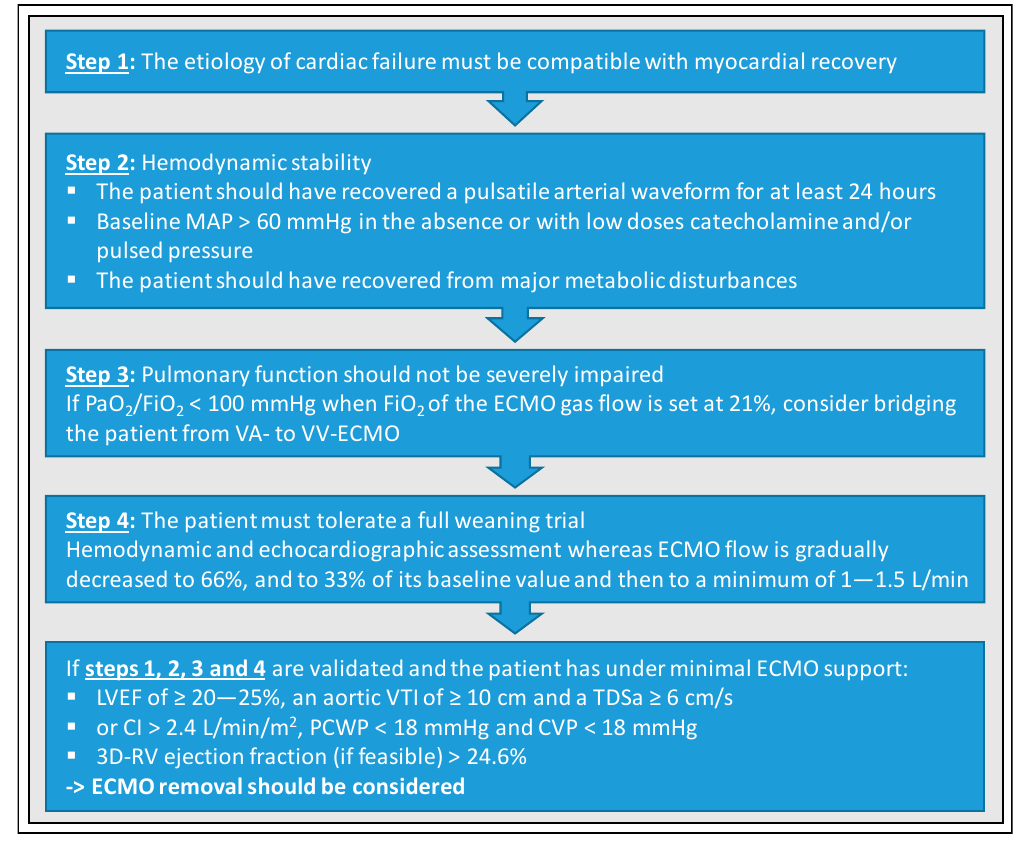
Figure 1. Standardized protocol for weaning from veno-arterial extracorporeal membrane oxygenation (VA-ECMO), according to Aissaoui et al. [21]. MAP, mean arterial pressure; PaO 2, Partial pressure of oxygen; FiO 2 , fraction of inspired oxygen; LVEF, left ventricular ejection fraction; VTI, velocity-time integration; TDSa, tissue Doppler lateral mitral annulus peak systolic velocity; CI, cardiac index; PCWP, pulmonary capillary wedge pressure; CVP, central venous pressure; RV, right ventricle.